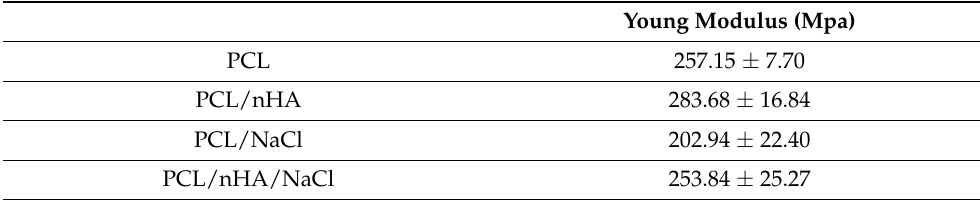
Figure 15. Stress–strain curves for the compressive mechanical tests carried out with the samples PCL, PCL/NaCl (PCL with pores), PCL/nHA, and PCL/nHA/NaCl (PCL + nHA with pores) in a dynamical regime. A magnification of the elastic zone could be observed. Table 3. Young modulus of the different materials analyzed.